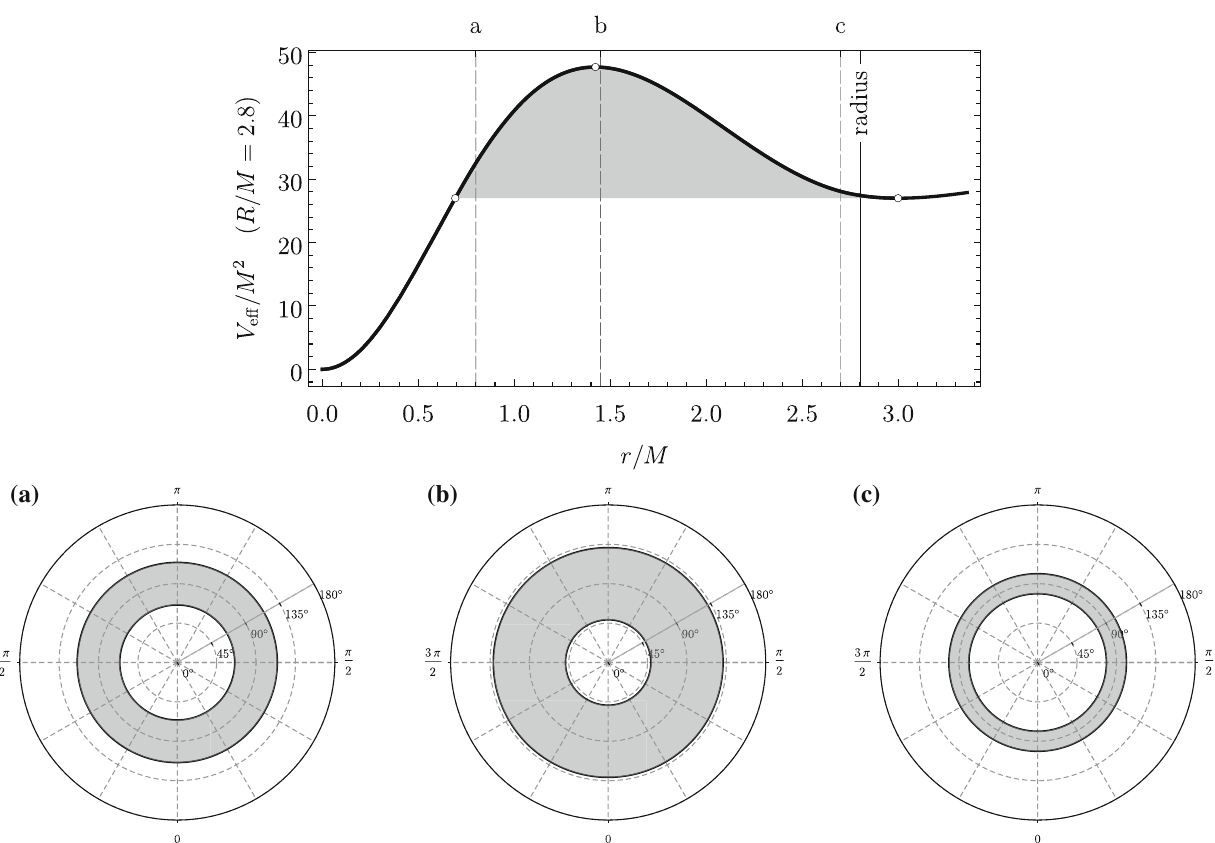
Fig. 6 The escaping/trapping cones corresponding to r / M = { 0 . 8 , 1 . 45 , 2 . 7 } for the Tolman VII configuration with R / M = 2 . 8. Above is shown the effective potential and marked positions indicate the locations where the cones are determined. The trapping zones are